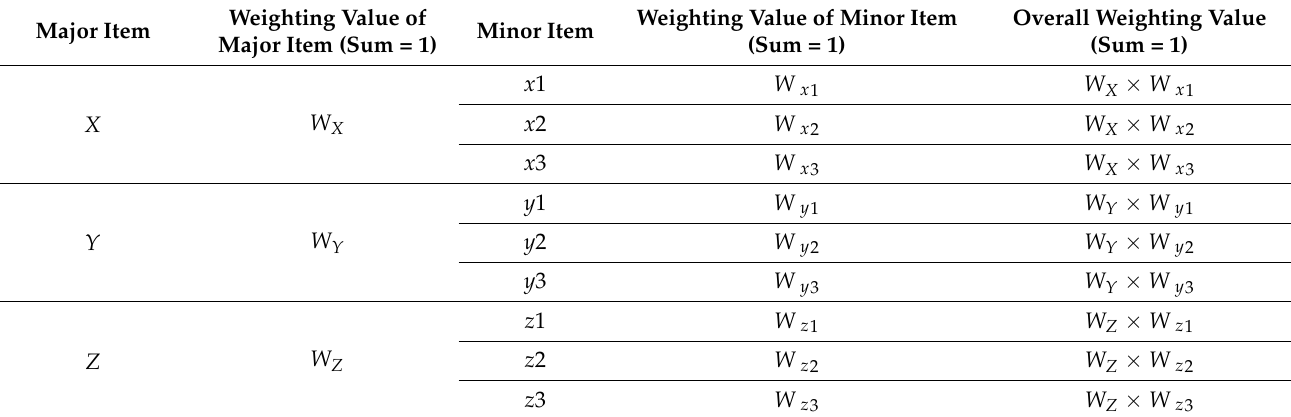
Figure 4. Part of the AHP questionnaire for the study. Table 2. Analytic hierarchy structure weighting schematic